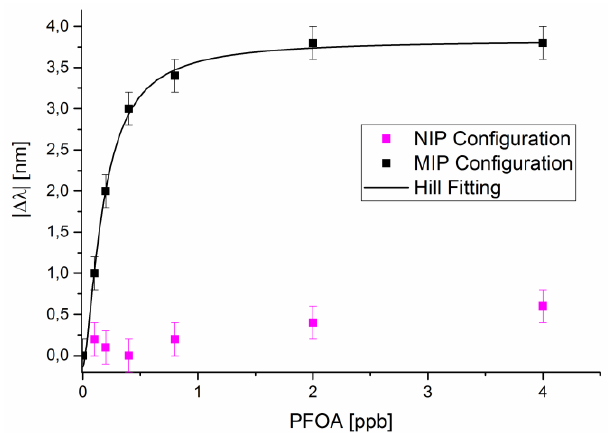
Figure 5. For MIP and NIP SPR-configurations, absolute plasmon resonance wavelength variation (| ∆ λ |), with respect to the blank (0 ppb), versus the concentration of PFOA (ppb) and Hill fitting to the experimental values (in MIP configuration).